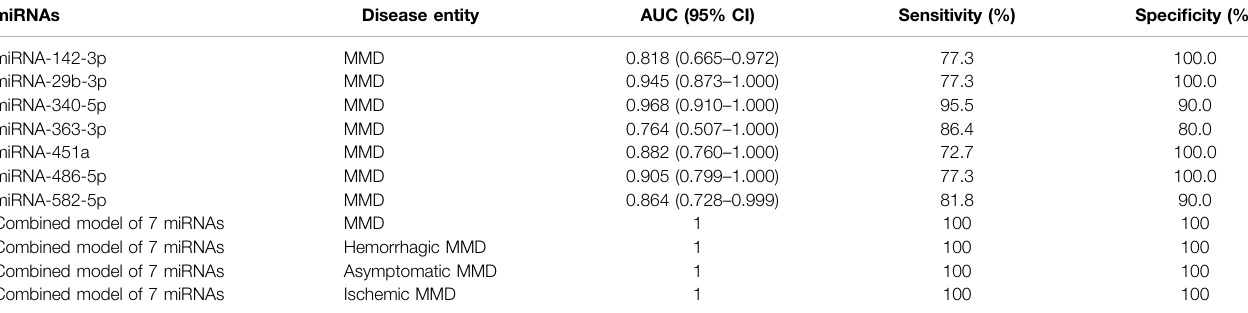
TABLE 4 | The details of the AUC, sensitivity, and speci fi city of each identi fi ed miRNA and combined model for diagnosis of MMD. miRNAs